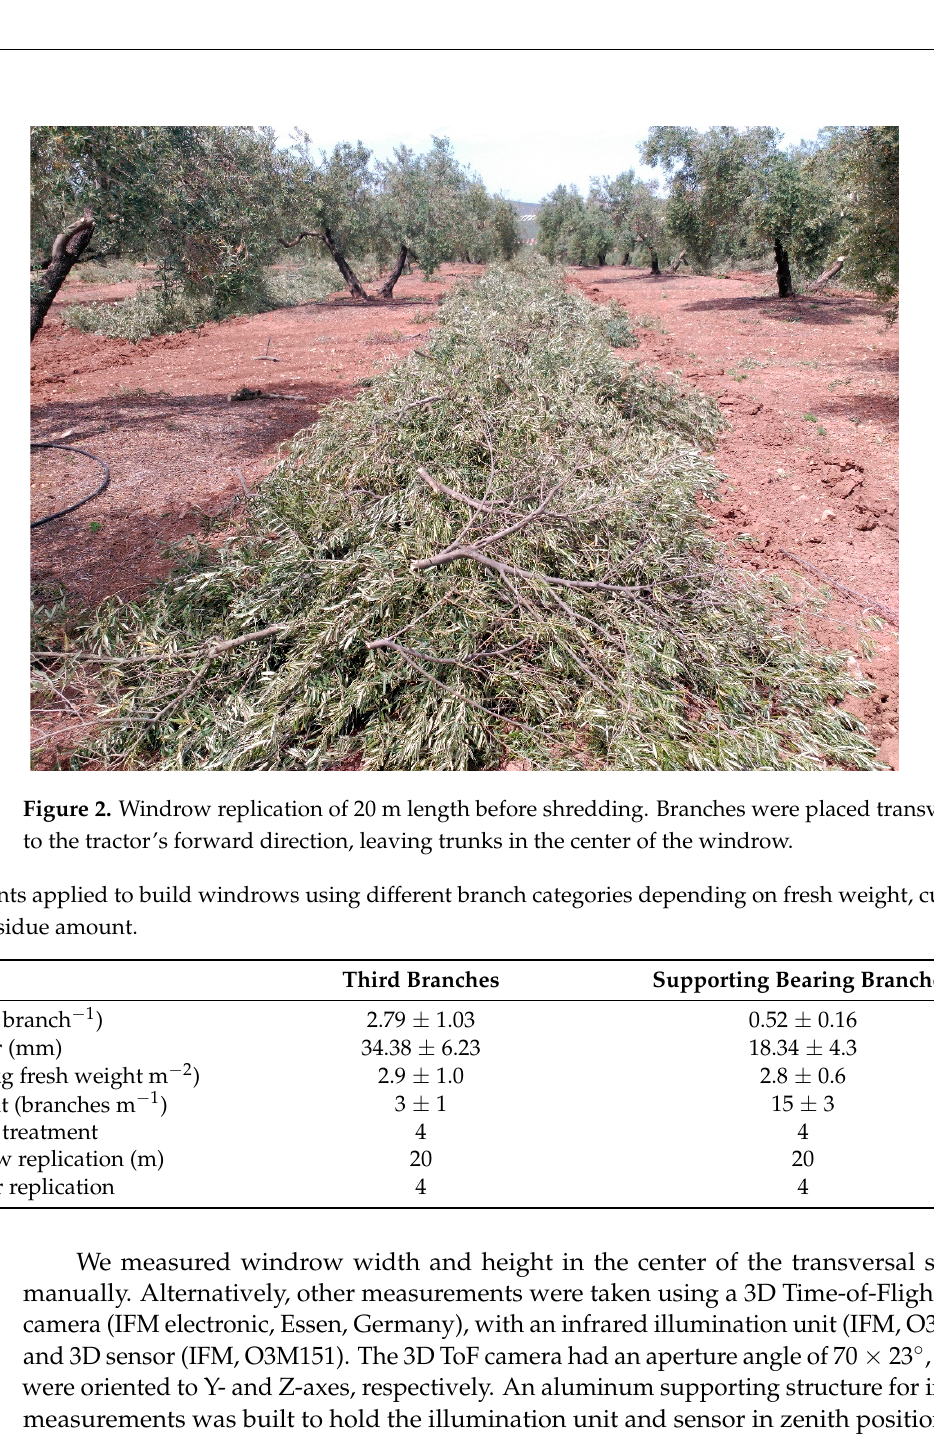
4 of 11 Table 1. The two treatments applied to build windrows using different branch categories depend- ing on fresh weight, cut diameter , and pruning residue amount. Value